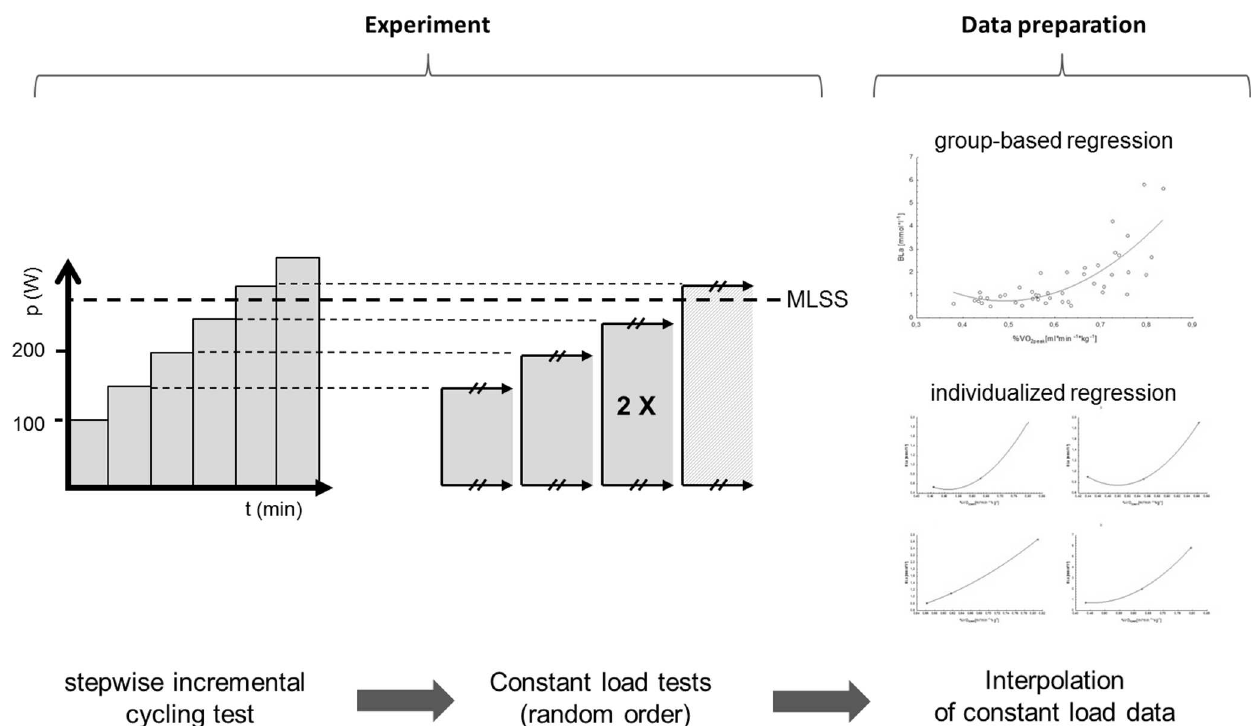
Fig 1. General Design. Subjects performed 1 stepwise incremental cycling test to exhaustion followedby 5 constant load tests with absolute intensities identicalto the steps of the incremental test. The constant load test with the highest workloadbelowthe maximum lactate steady state (MLSS) was repeated. In analogy to the performance curves routinely generatedfrom stepwise incremental exercise tests, load dependent courses were deducedfrom measurements during the constant load tests. Group-based as well as individualregressionwas implemented to assess potential increases in predictive accuracy with individualization. P (W) = Performance in watt; t (min) = time in minutes.